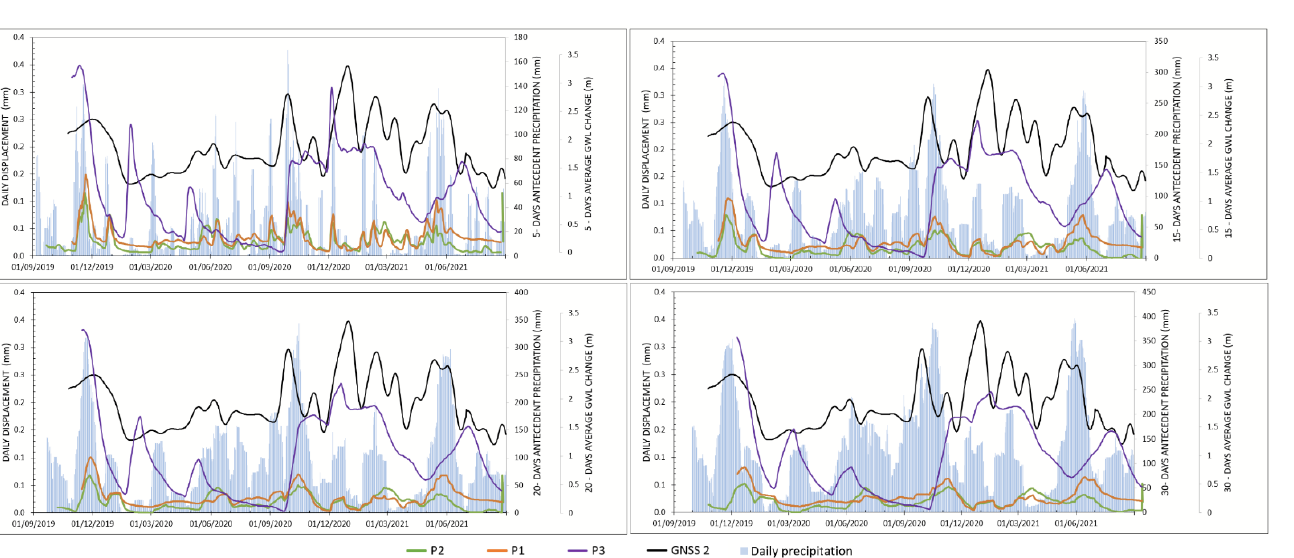
Figure 6. Time-series diagram showing the relationship among the daily displacements obtained by GNSS2; 5-, 15-, 20-, and 30-day antecedent precipitation; and 5-, 15-, 20-, and 30-days of average change in the groundwater table.